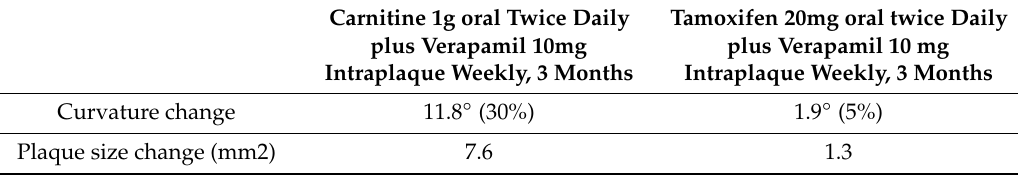
Table 14. Carnitine vs. Tamoxifen: Randomized,